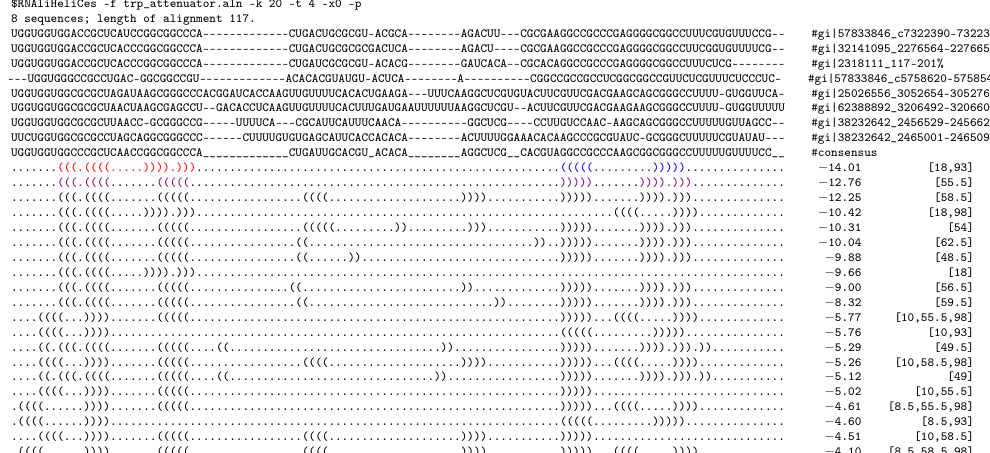
Figure 4. The first 20 hishapes of the trp -attenuator [18–20]. Following the alignment, hishape representative structures ( hishreps ) are shown with their pseudo free energy (in kcal/mol) and the corresponding hishape .